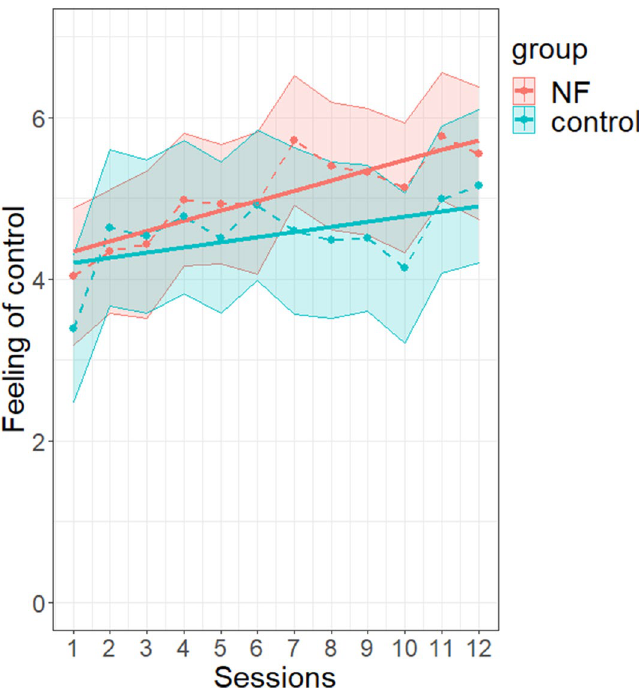
Figure 7. Evolution of the between-session effect of feeling of control with NF learning. See Fig. 3 for legend. Graph was obtained with R software (v.4.0.2; R Core Team,